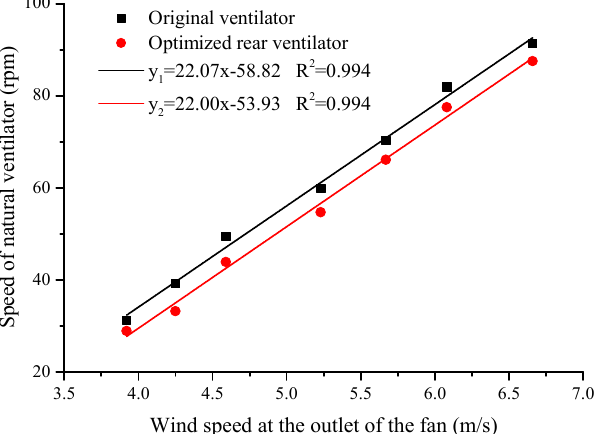
Figure 19. Relationships between wind speed in the air duct and natural ventilator speed before and after optimization.